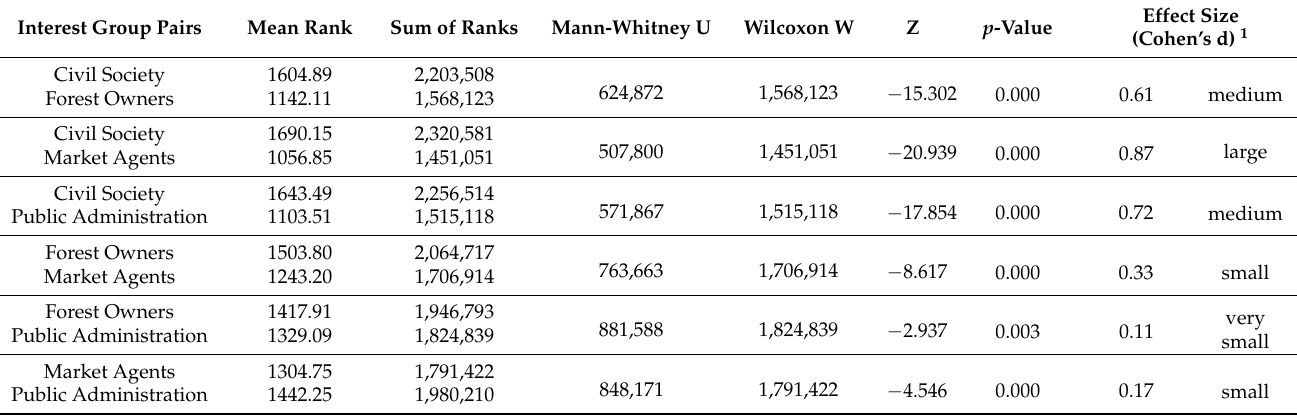
Table 5. Results of the Mann–Whitney U-Test for ranks of priority scores for the 1373 management units and effect size (Cohen’s d) by pair of interest groups.